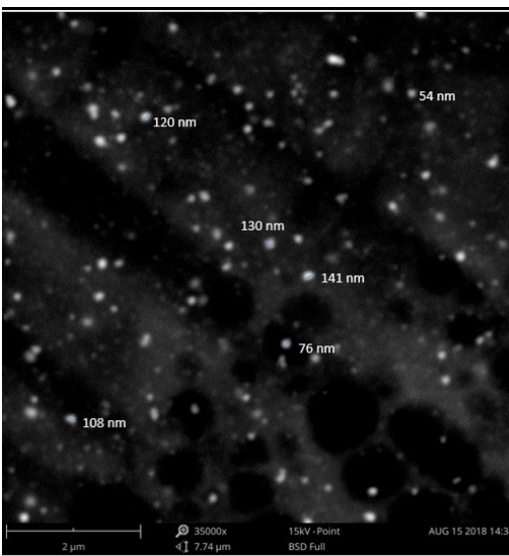
Figure 2. Micrograph obtained by SEM for AgNP-65 sample (λ = 632 max,1